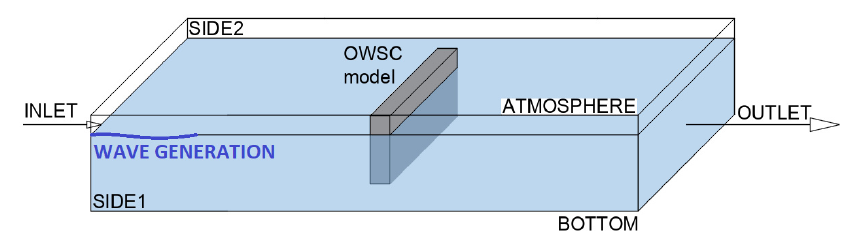
Figure 3. Schematic of the numerical model, including the tank and the wave energy device.